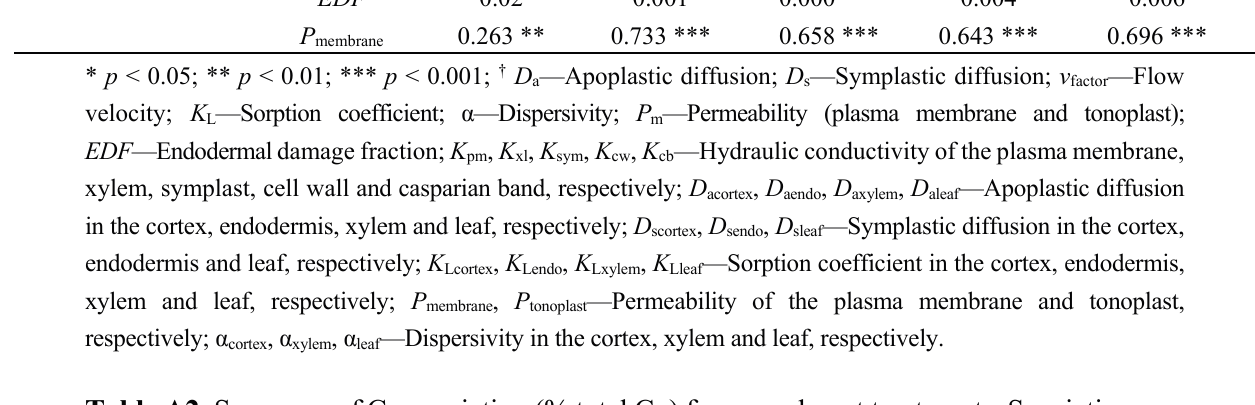
Table A2. Summary of Cu speciation (% total Cu) for amendment treatments. Speciation was modeled using VisualMINTEQ